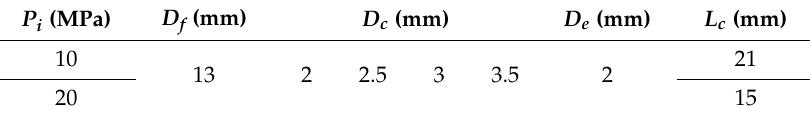
Table 3. The parameters of the organ-pipe nozzles used in the experiment.